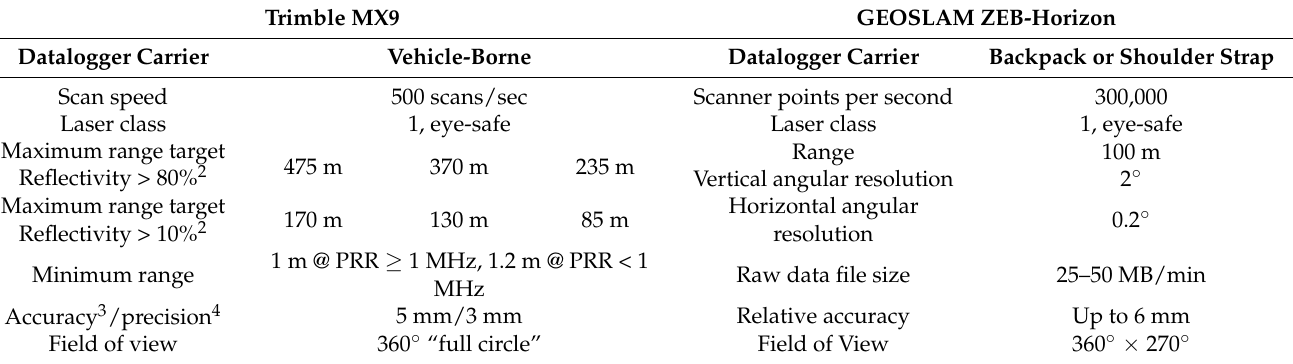
Table 1. Some of the parameters of the two